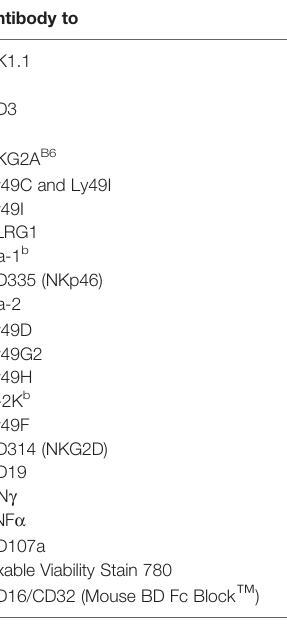
TABLE 1 | List of antibodies used. Antibody to